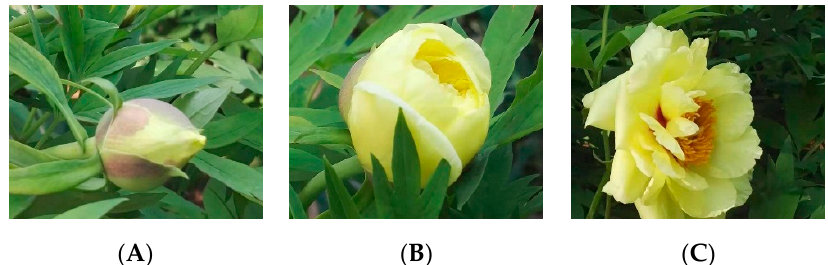
Figure 1. Pictures of Paeonia suffruticosa flowers at the different flowering stages. ( A ) P. suffruticosa flowering bud; ( B ) P. suffruticosa flower at the early flowering stage; ( C ) P. suffruticosa flower at the full flowering stage.